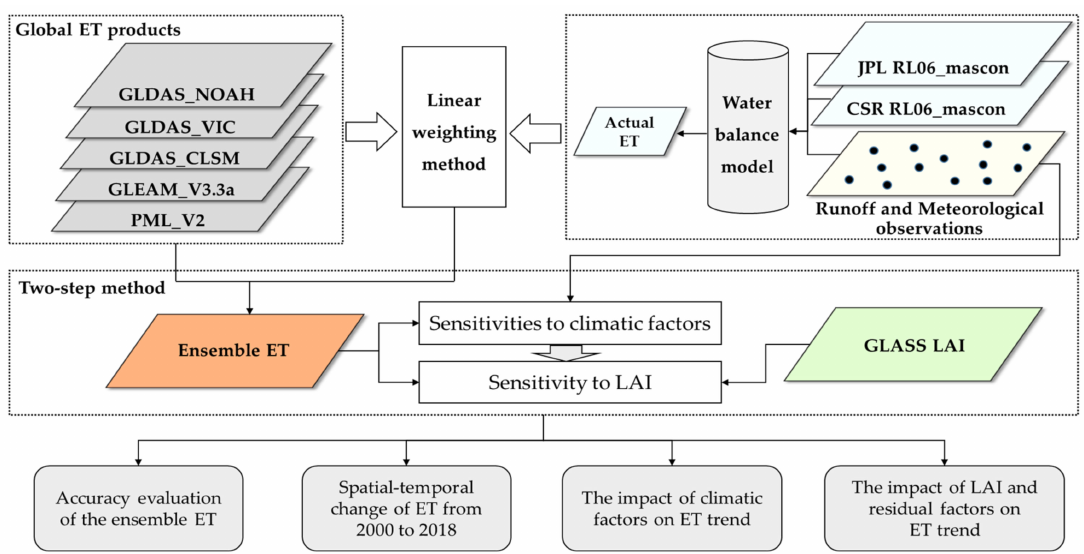
Figure 2. Overall flow scheme of this